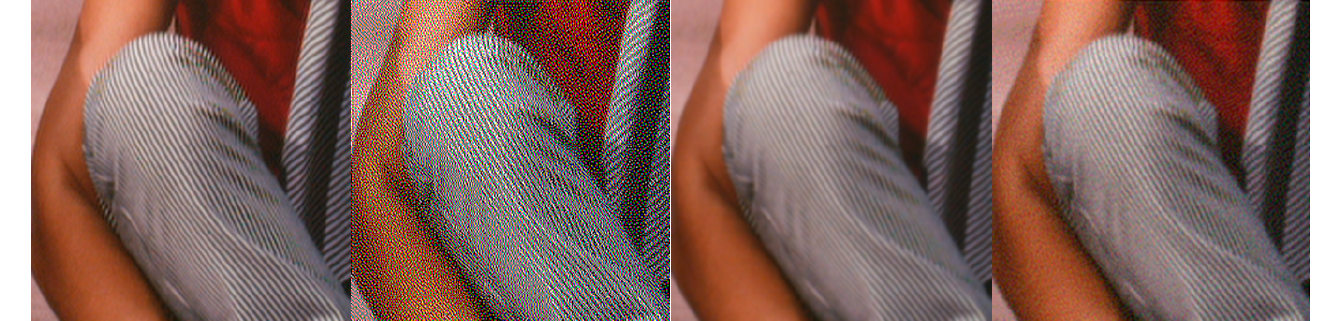
Figure 2. Original, halftoned, blurred original, and blurred halftoned images (left to